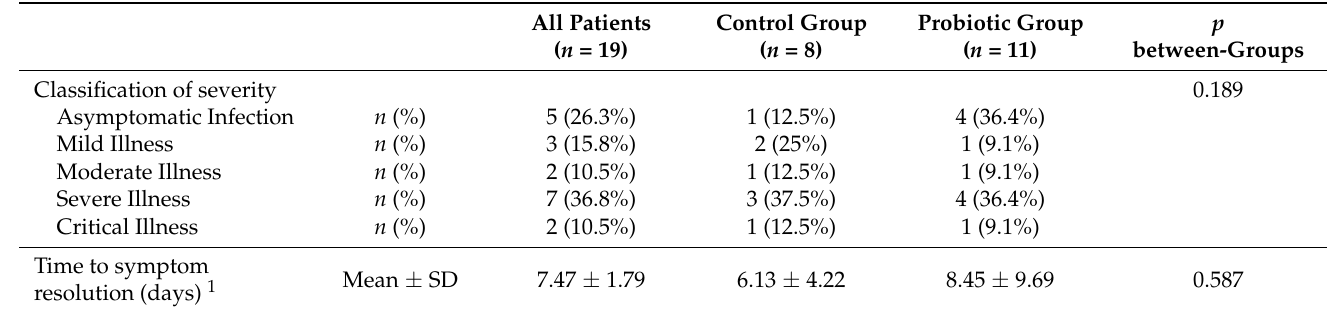
Table 2. Classification of severity and duration of the infection in Covid-19 patients by interven- tion